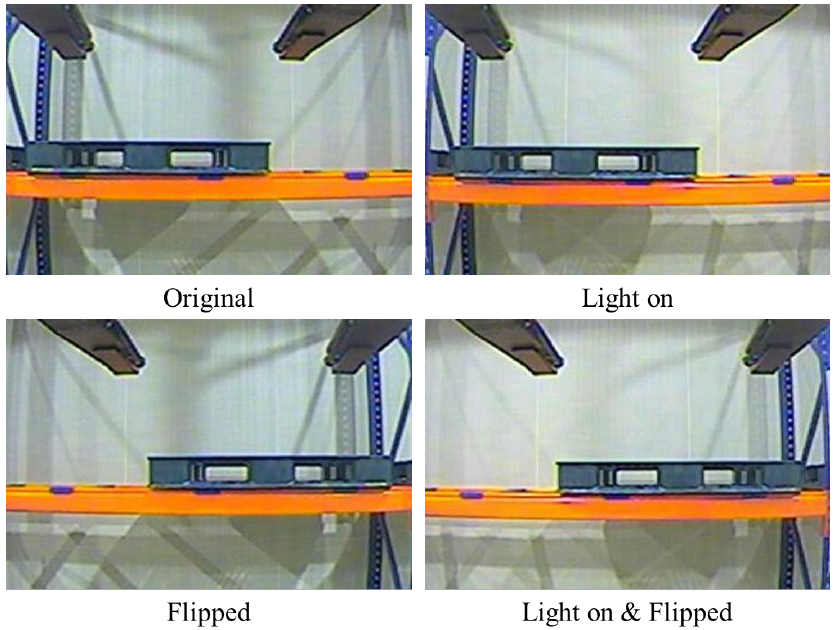
Figure 5. Four types of images in training